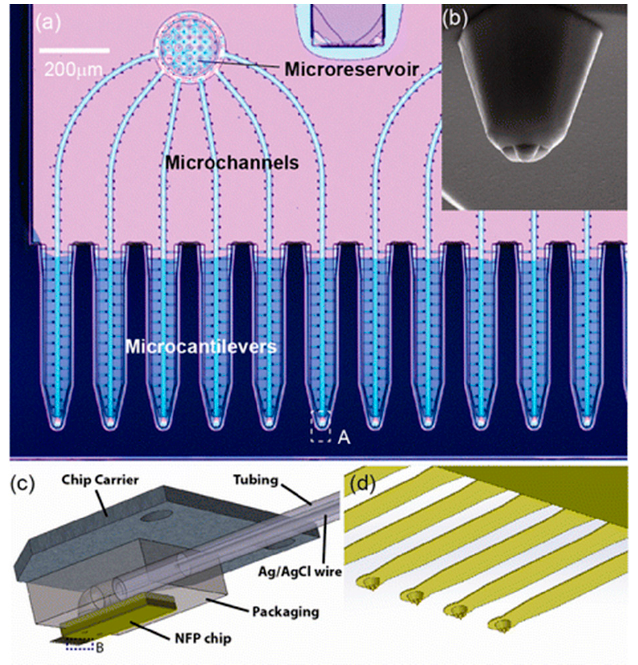
Figure 11. Nanofountain probe device: ( a ) optical microscopy image of the NFP with multiple probes for parallelized single-cell electroporation; ( b ) SEM image of a view of the probe; ( c ) Illustration of the packaged NFP chip; ( d ) magnified view of the cantilevers in region B of ( c ). Reprinted with permission from ref. [101]. Copyright © 2013 American Chemical Society.